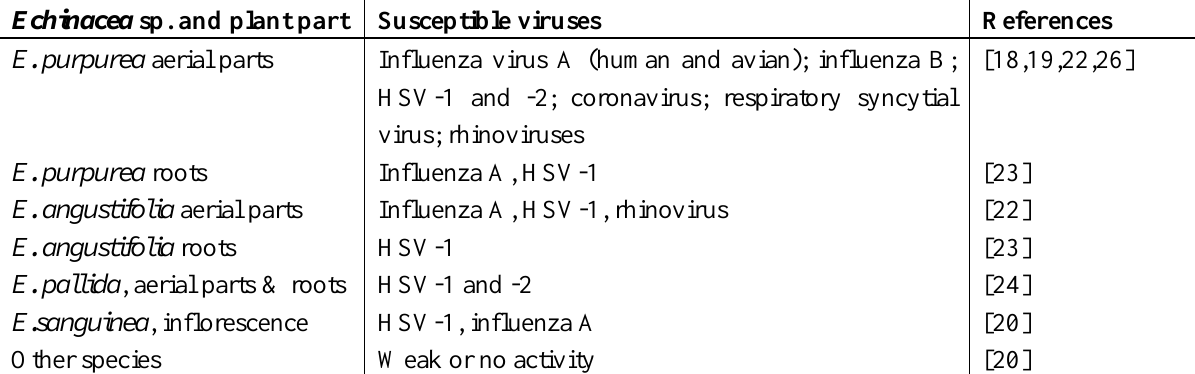
Table 3. Antiviral activities of Echinacea